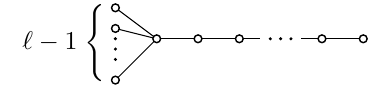
Figure 1: The graph S n,(cid:96) mentioned in Theorem